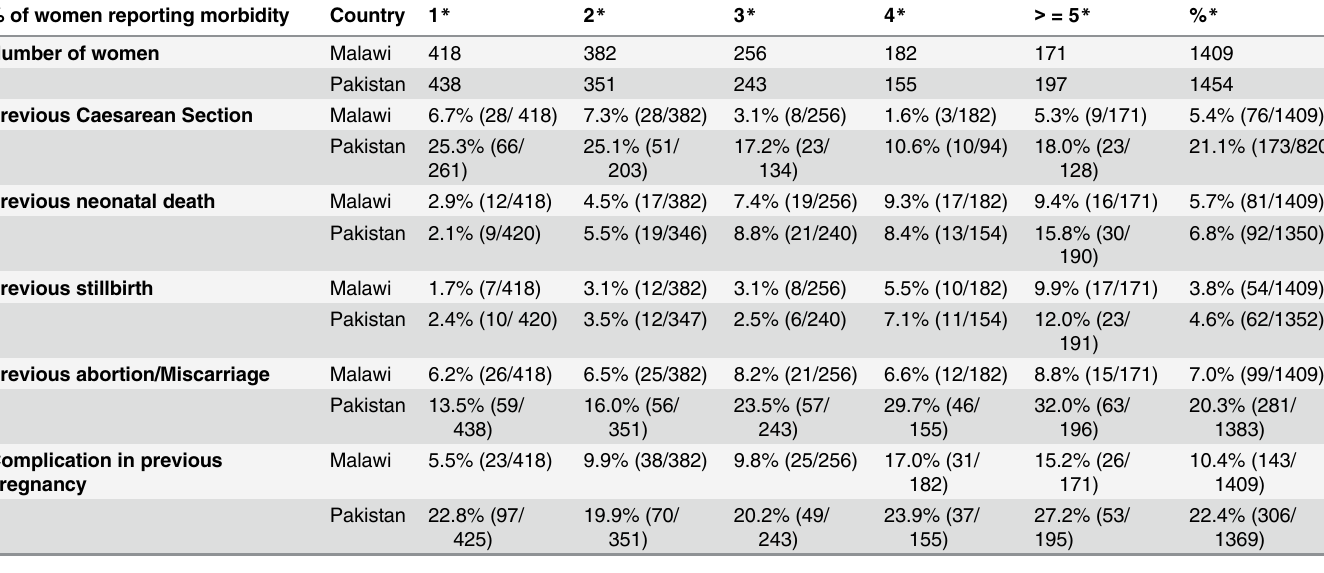
Table 2. Number and proportion of women who reported morbidity during previous pregnancy, by parity status. % of women reporting